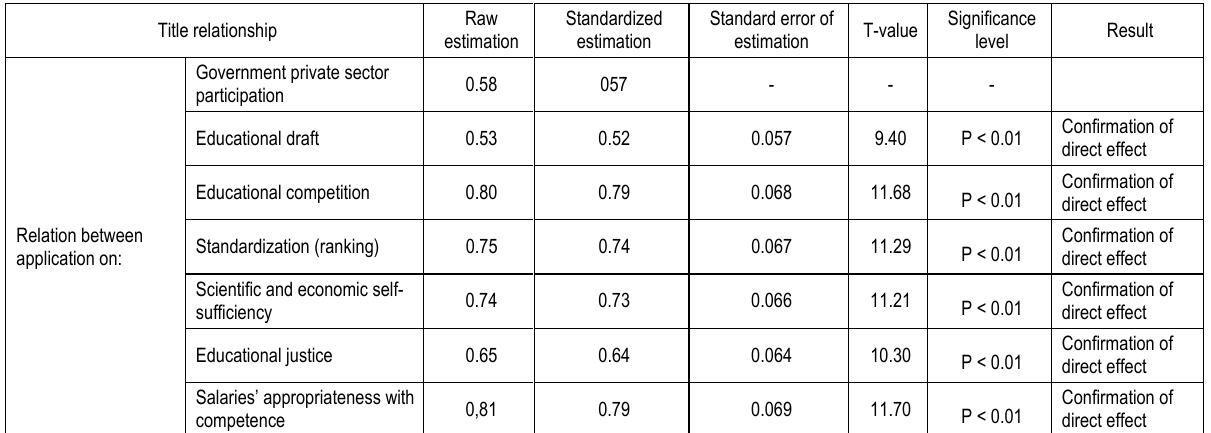
Table 6. Direct values measurement